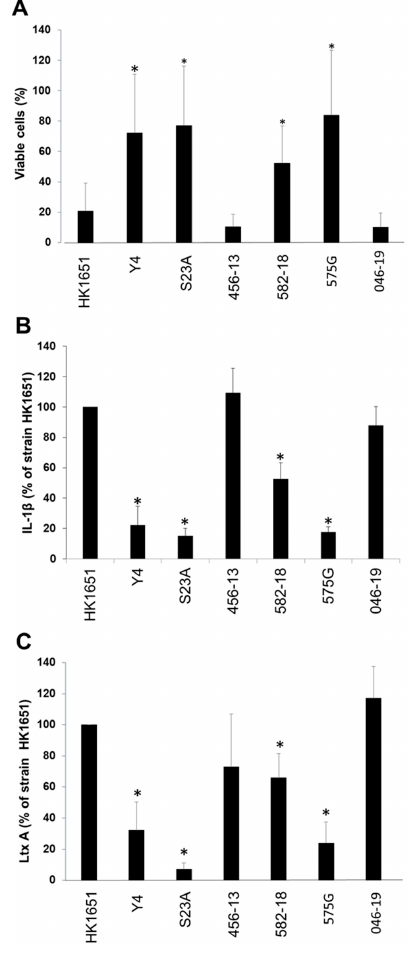
Figure 6. Leukotoxicity of A. actinomycetemcomitans strains with di ff erent leukotoxin promoters and significant di ff erences ( p < 0.05) from the JP2 genotype are indicated (*). ( A ) The leukotoxicity was quantified as killing of THP-1 cells by leukotoxin extracted from the bacterial cells. Cell viability was monitored as quantification of neutral red uptake in the exposed THP-1 cells. MOI 100, that is, extracts from 10 8 bacterial cells was incubated with 10 6 THP-1 cells for 2 h. Mean ± SD of five experiments is shown. ( B ) The leukotoxicity was quantified as leukotoxin-induced release of IL-1 β from THP-1 cells. Released IL-1 β was quantified by ELISA-based technique. MOI 10, that is, extracts from 10 7 bacterial cells were incubated with 10 6 THP-1 cells for 2 h. Mean ± SD of three experiment is shown. ( C ) The production of leukotoxin was quantified by a checkerboard-based technique, including the usage of leukotoxin antibodies. Mean ± SD of five di ff erent experiments is